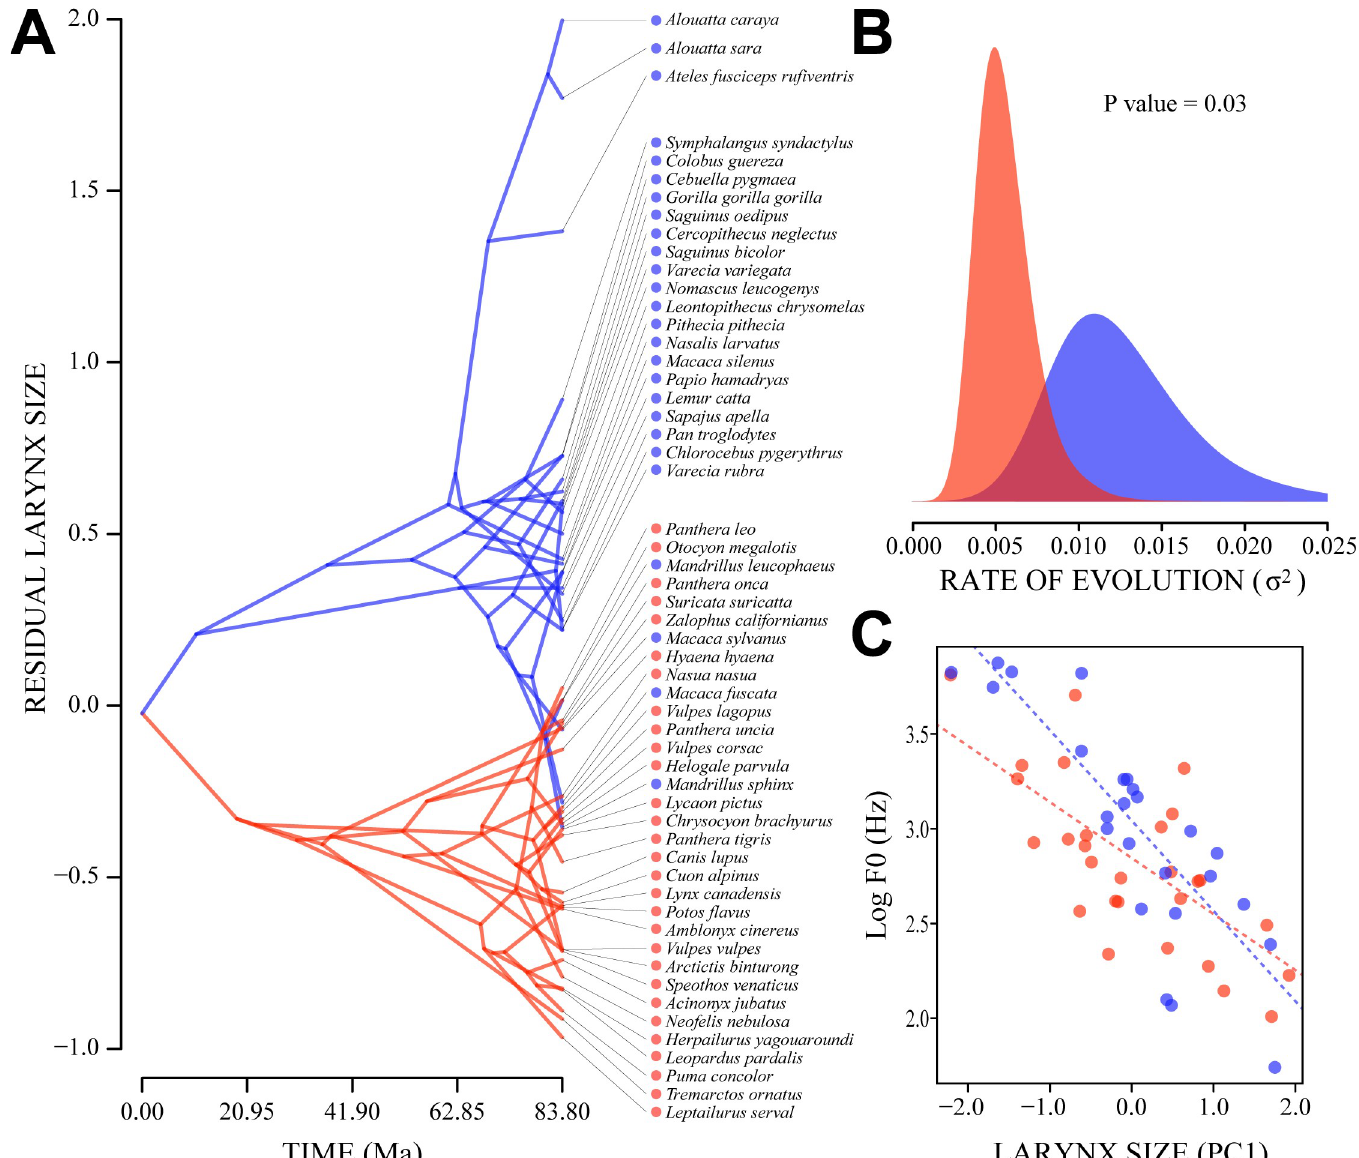
Fig 4. Evolutionary rate analyses. (A) Ancestral phenogram depicting divergence times plotted against residual larynx size from a pGLS regression of larynx size to log body length. Primate lineages (blue) are characterized by larger and more variable values than those of carnivoran lineages (red), as well as faster rates of change. (B) Probability density plots indicating the distributions of evolutionary rates required to produce the variance in residual larynx size observed in primates (blue) and carnivorans (red). The P value is the result of a permutation analysis of primate-to-carnivoran rate ratios (see Methods) and affirms the hypothesis that the two distributions are significantly different. (C) A comparison of larynx size and log mean-F0 in species-typical vocalizations (data from [9]). See S1 Fig for a labeled version of C. The data used to create Fig 4A and 4B are located in S1 Data, sheet B, columns B and C. The data used to create Fig 4C are located in S1 Data, sheet B, columns C and K. F0, fundamental frequency; PC1, first principal component; pGLS, phylogenetic generalized least